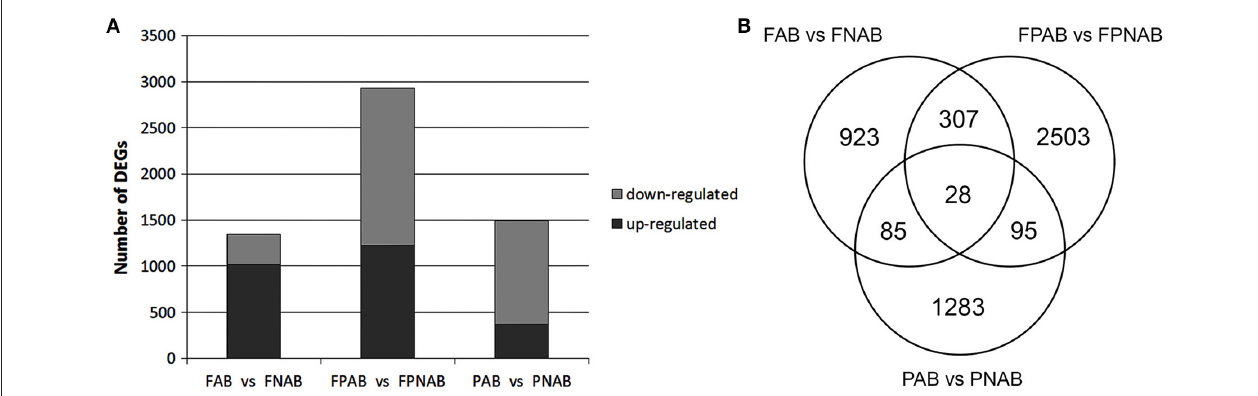
FIGURE 4 | Regulated characteristics of differentially expressed unigenes (DEGs) in each comparison. (A) Three comparisons of L . luteus abscising flowers and non-abscising flowers (FAB vs. FNAB), abscising flower pedicels and non-abscising flower pedicels (FPAB vs. FPNAB), and abscising pods and non-abscising pods (PAB vs. PNAB) are shown. (B) Venn diagram showing the amounts of common and unique DEGs for the compared transcriptome libraries.